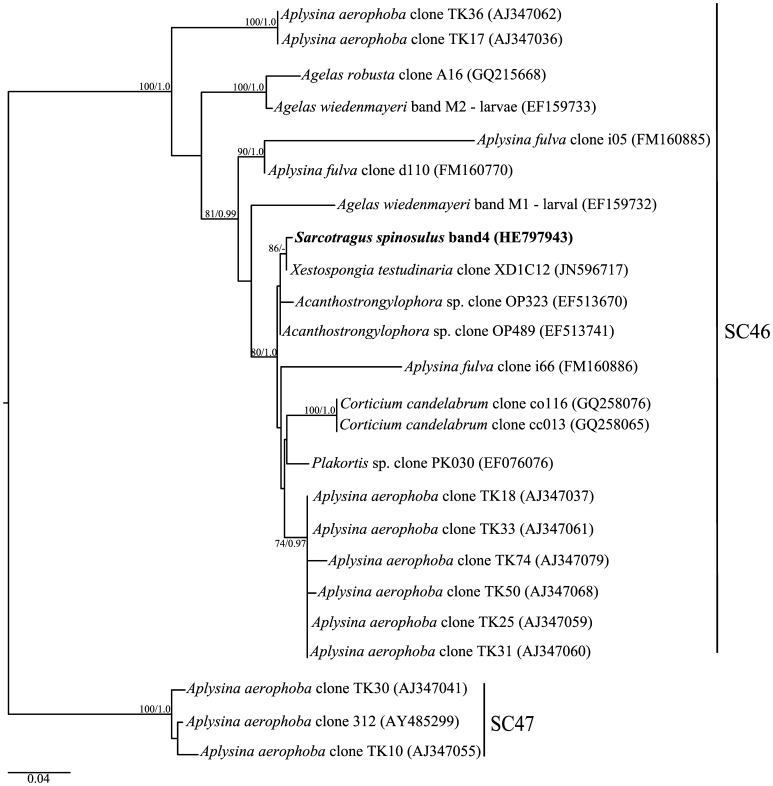
Phylogenetic inference of Chloroflexi 16S rRNA genes.Tree construction procedure was as described for Figure 4, except that sequences from SC46 were selected along with sequences from SC47, which were used as outgroup [34]. The Maximum Likelihood tree is shown (-ln likelihood: 3791,095).